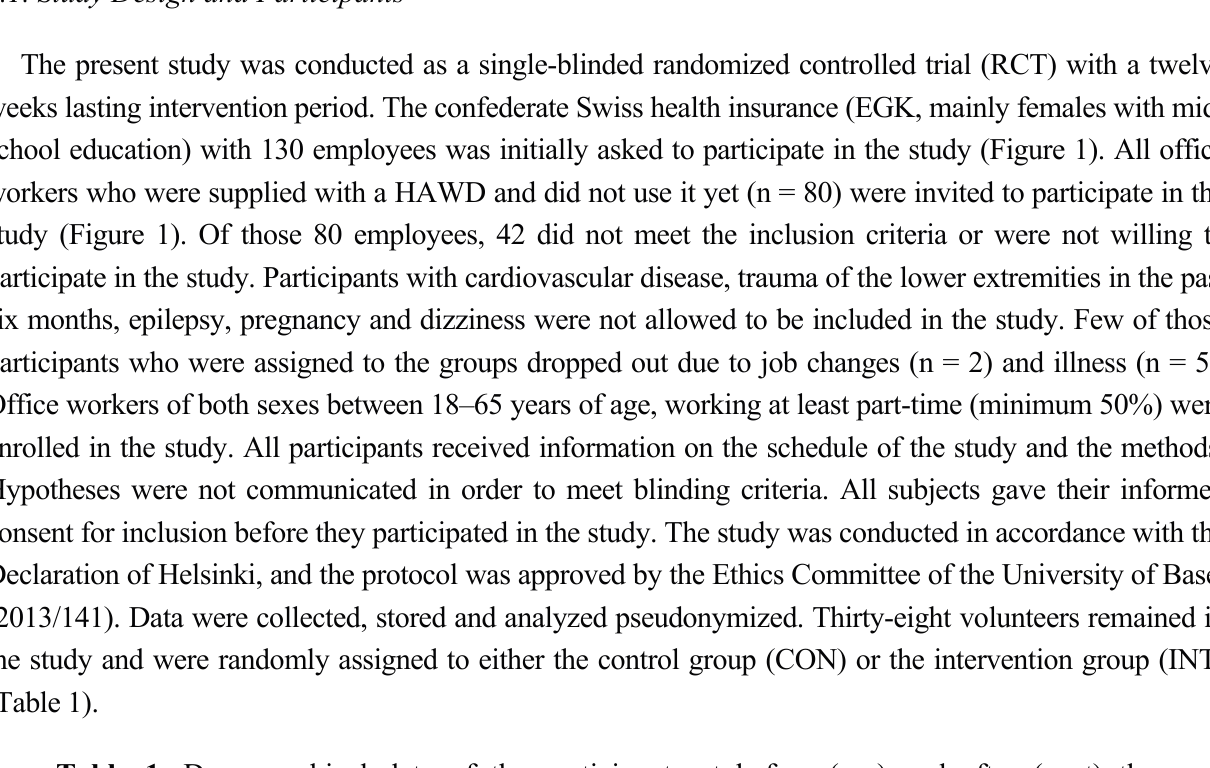
Table 1. Demographical data of the participants at before (pre) and after (post) the 12 week intervention for the intervention group (INT) and control group (CON). Data are presented as means ± standard deviations